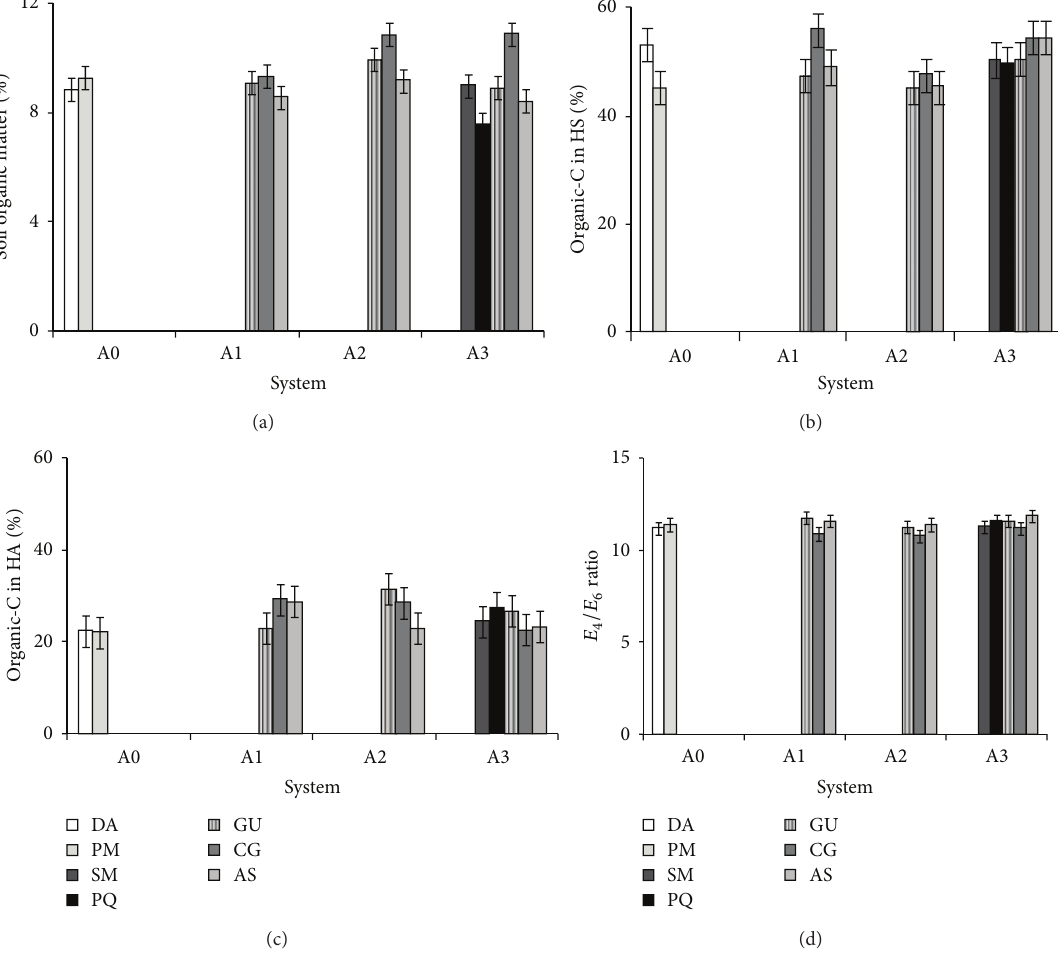
Figure 2: Soil organic matter content, carbon in humic substances, and 𝐸 4 / 𝐸 6 ratio of soils associated with pastures and tree species in multistrata silvopastoral systems in the Sinu Valley, Colombia. Abbreviations: D. aristatum (DA); P. maximum (PM); G. ulmifolia (GU);